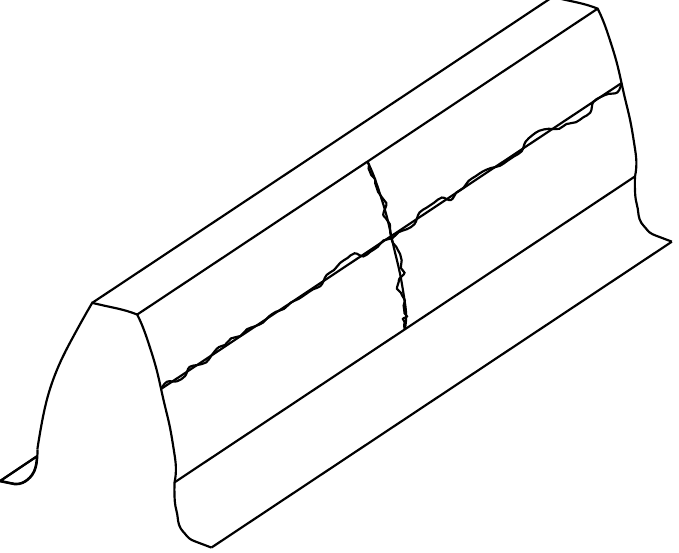
Figure 14. Location of the profile and lead line measurement at the gear